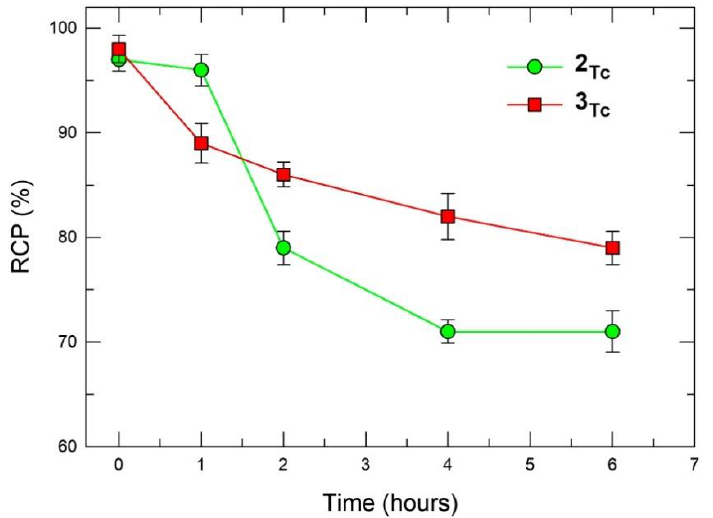
Figure 5. Stability study of complexes 2 Tc and 3 Tc in mouse serum (mean ± SD; n = 3).